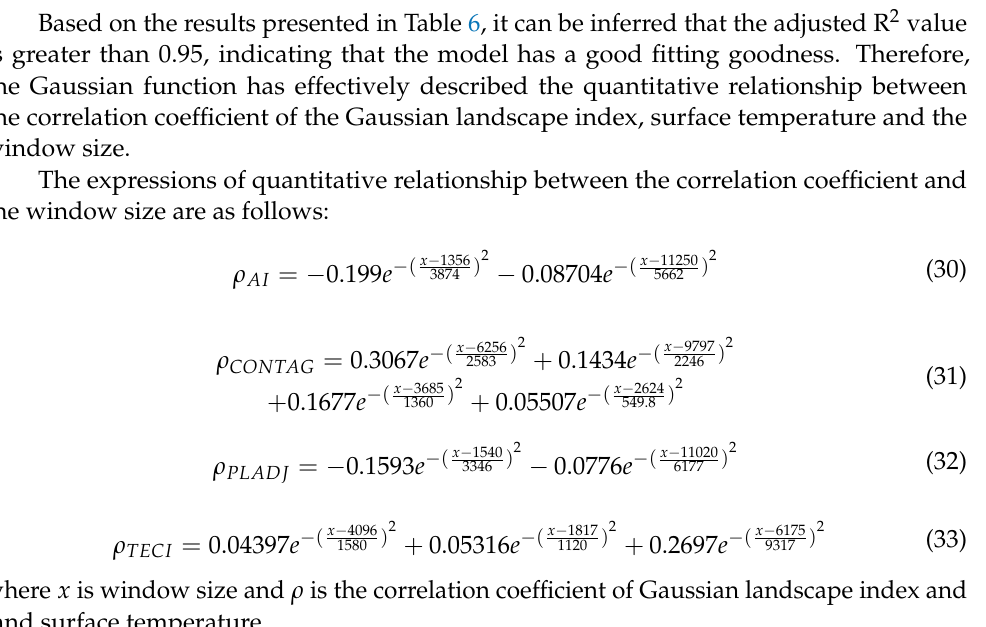
Table 6. The table of fitting effect of Gaussian landscape index. Landscape Index AI CONTAG PLADJ TECI Adjusted R 2